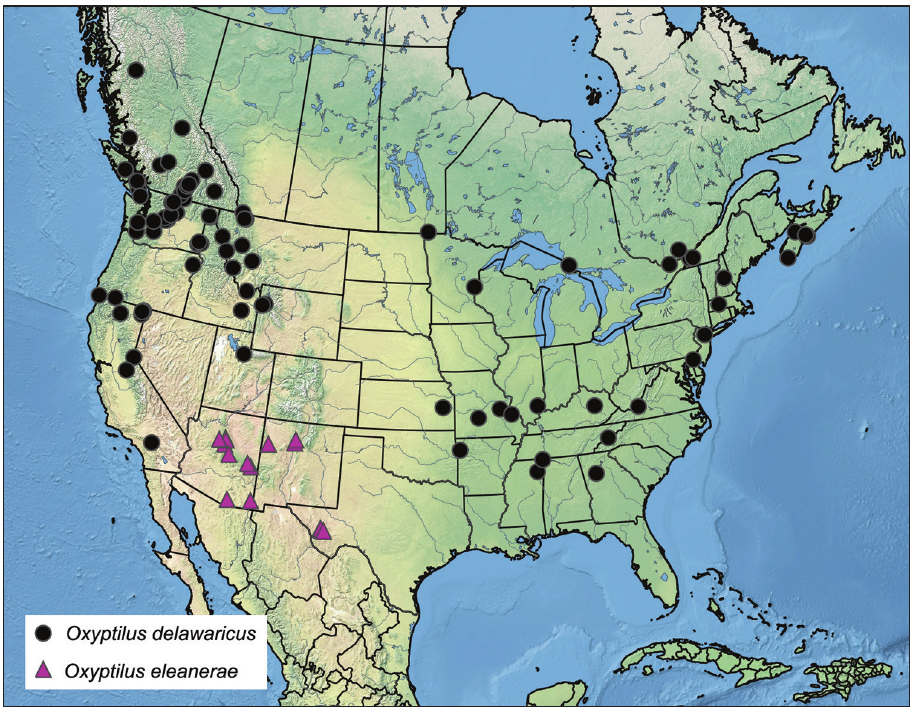
Figure 31. Distribution of Oxyptilus delawaricus and O. eleanerae . Assembled with simplemappr.net, accessed March